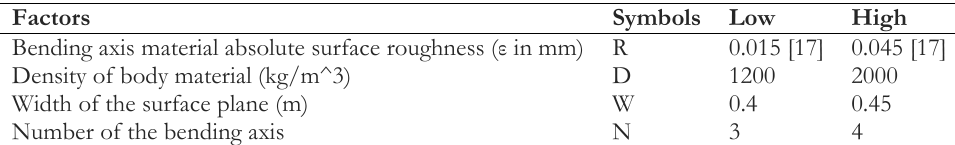
Table 1. Factor’s symbols and